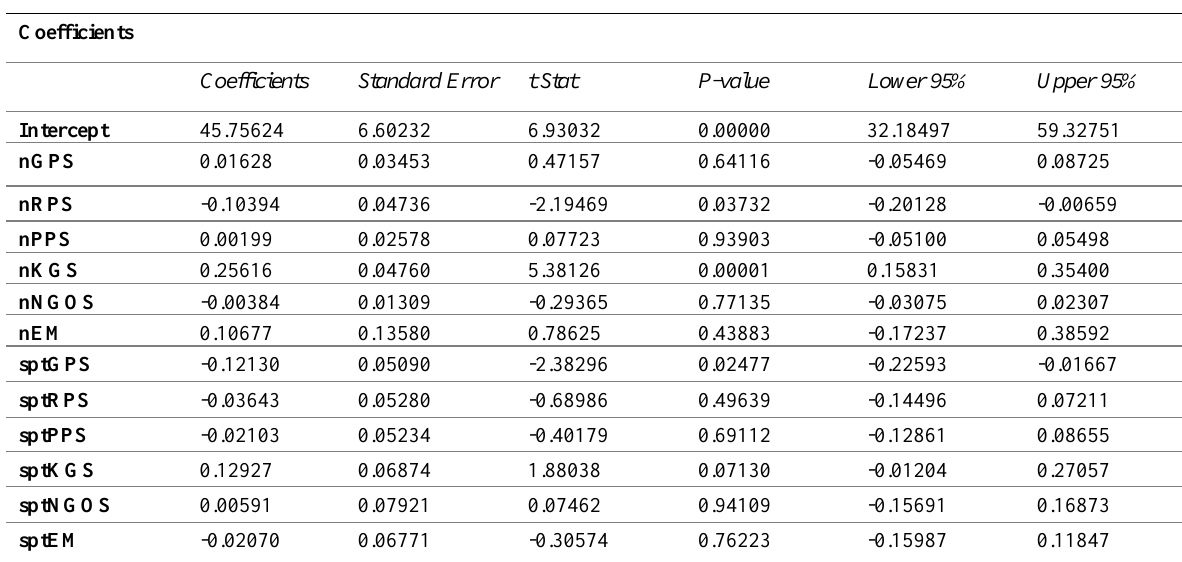
Table 27: Coefficients (Sylhet